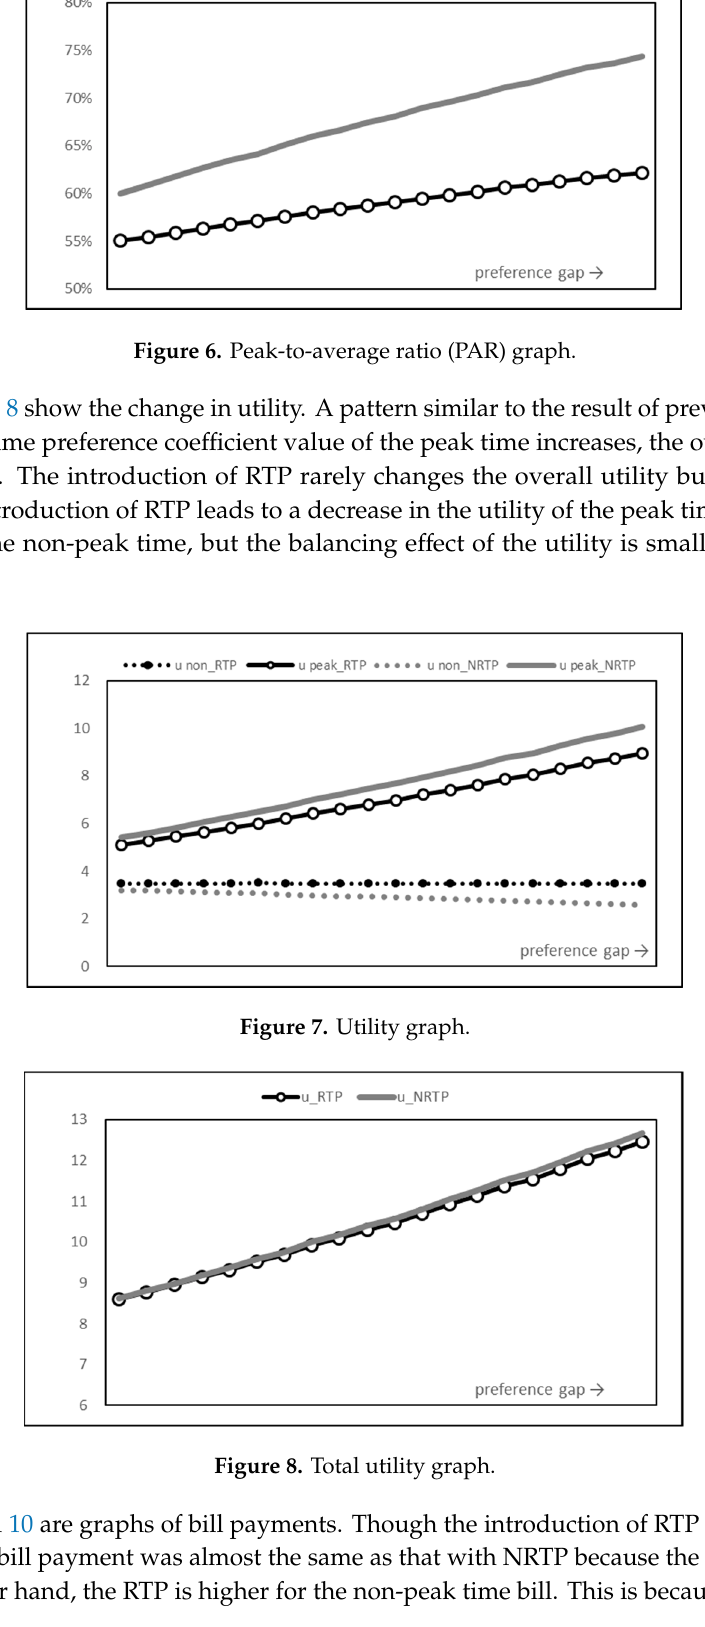
Figure 9. User bill payment graph.